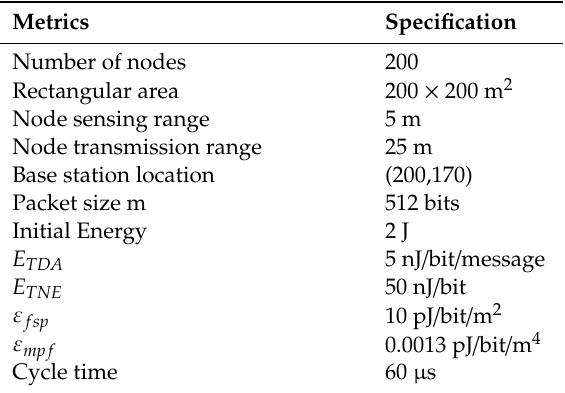
Table 2. Modeling